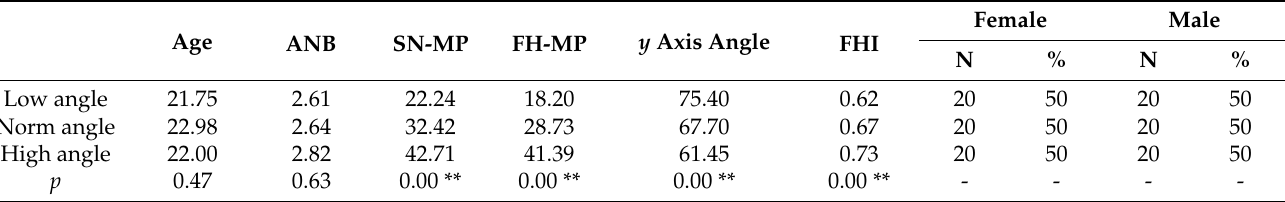
Table 2. The mean age, cephalometric measurements, and sex distribution of each